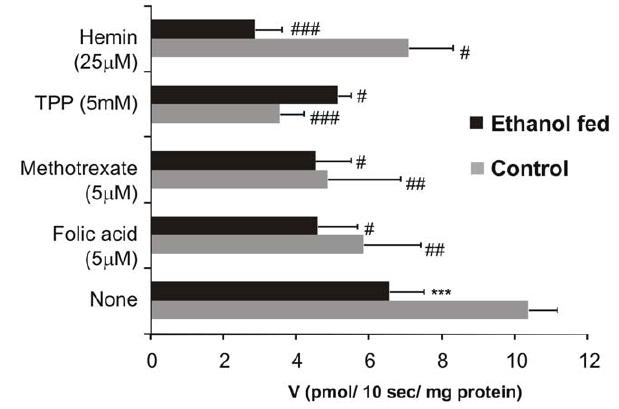
Figure 1. Folate uptake in pancreatic plasma membrane vesicles. Uptake of 5-[ 14 C]-MethylTHF (0.5 m M) was measured in a buffer of pH 5.0 [100 mM NaCl, 80 mM mannitol, 10 mM HEPES, 10 mM 2-morpholinoethanesulfonic acid pH 5.0] for 10. Each point represents the mean 6 S.D. of four determinations. **p , 0.01 vs. Control.